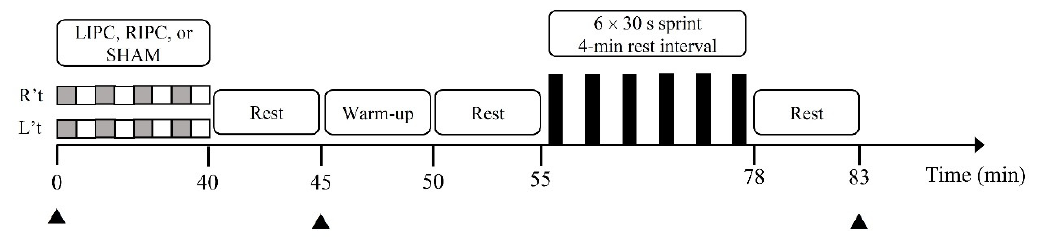
Figure 1. Protocol schematic. R’t, right thigh or upper arm; L’t, left thigh or upper arm; LIPC, local ischemic preconditioning; RIPC, remote ischemic preconditioning; ■ , Occlusion; □ , Reperfusion; ▲ , Blood lactate and pH value.